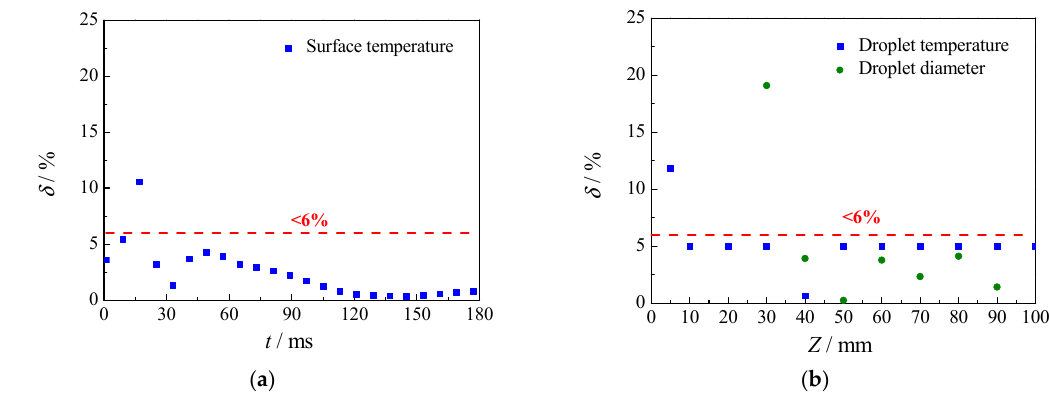
Figure 9. Relative errors between experimental and simulated results: ( a ) surface temperature of skin tissue and ( b ) droplet temperature and diameter.